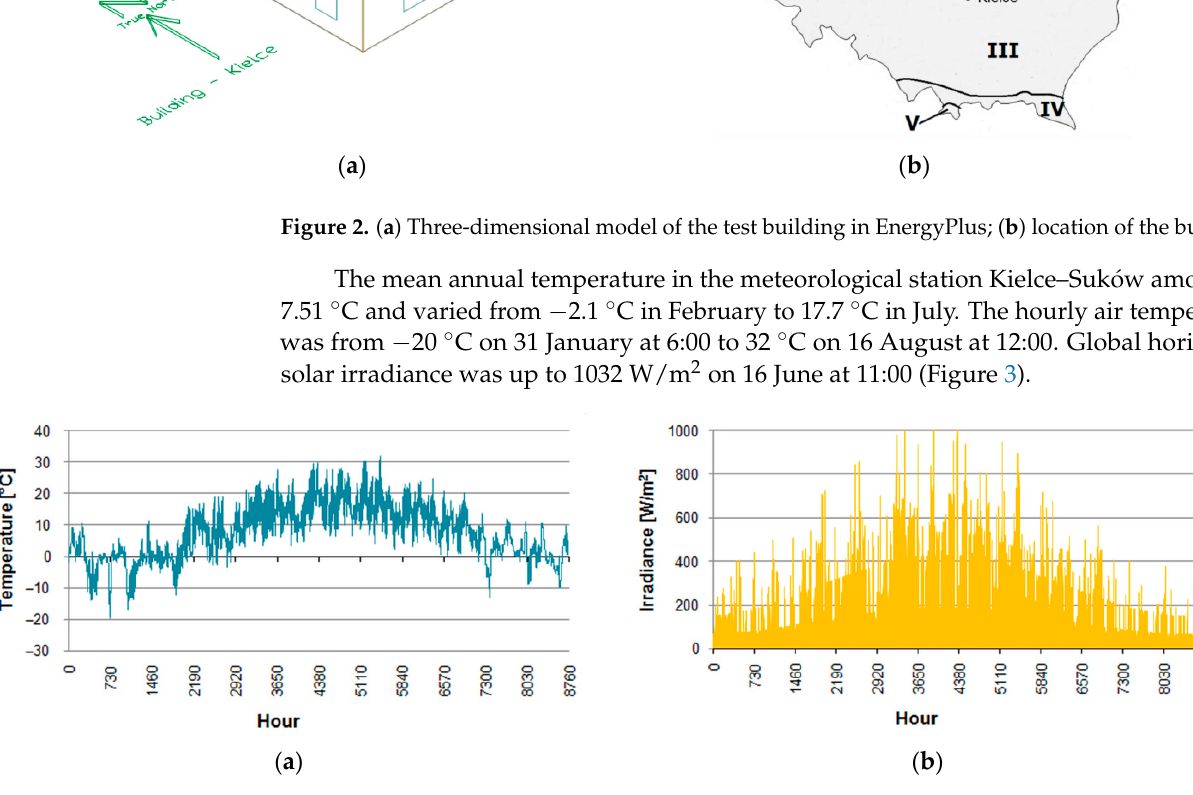
Figure 3. TMY for Kielce: ( a ) outdoor air temperature; ( b ) global horizontal irradiance.